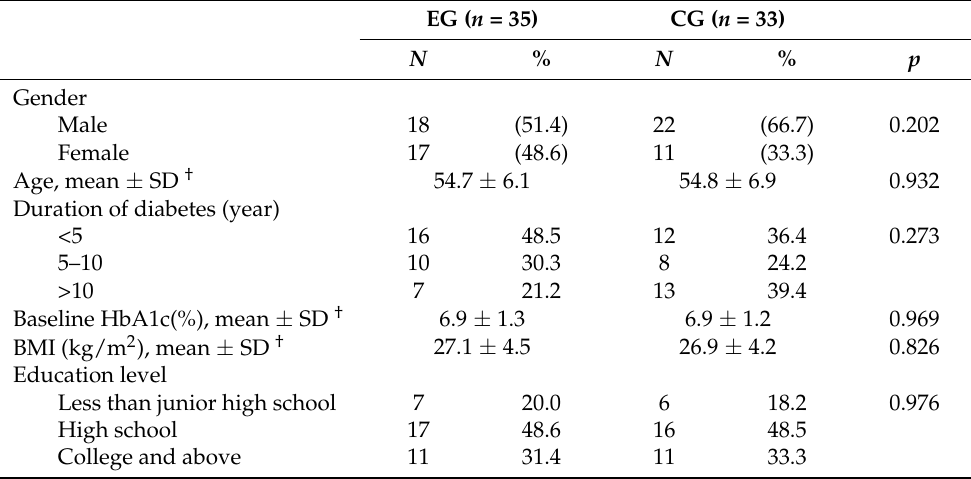
Table 1. Distribution of sociodemographic characteristics in patients with T2DM.